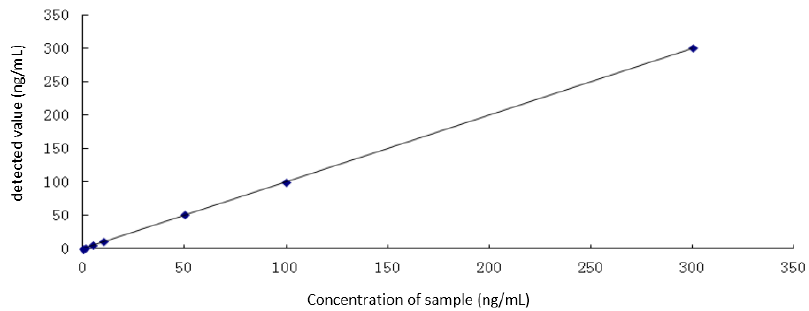
Figure 3. Standard curve for iodine.